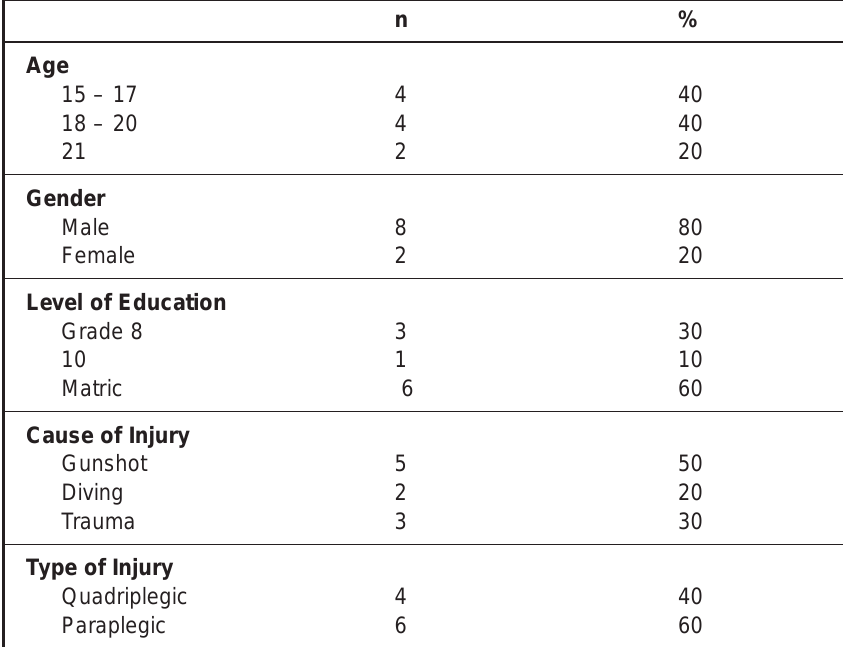
Table 1: Demographic profile of youth with Spinal Cord